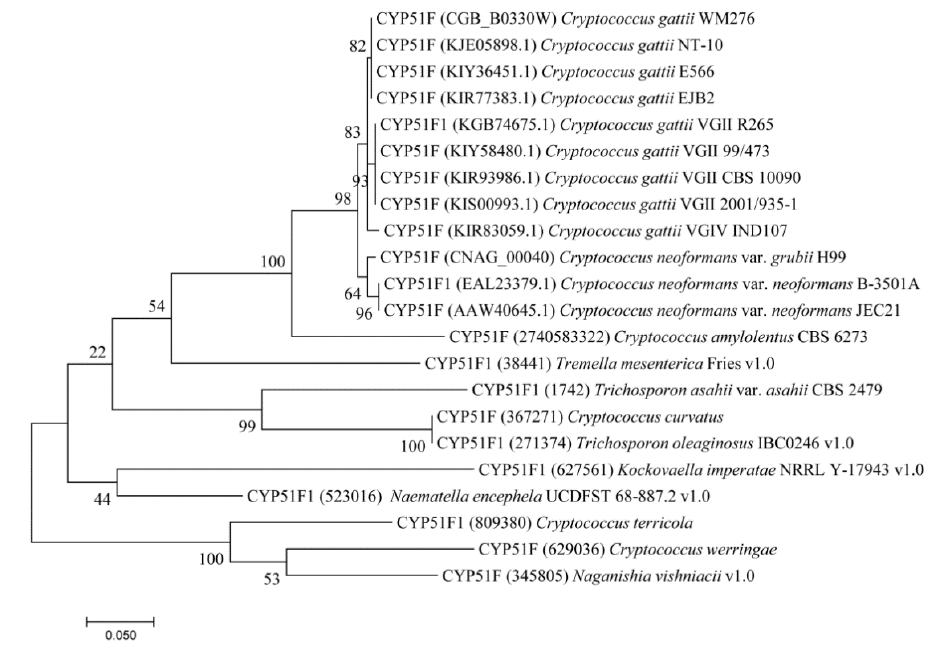
Figure 1. Phylogenetic analysis of CYP51s from Tremellomycetes. The analysis involved 22 CYP51 protein sequences. Phylogenetic analysis was carried out as described in the Methods section and the percentage of trees in which the associated taxa clustered together is shown next to the branches.